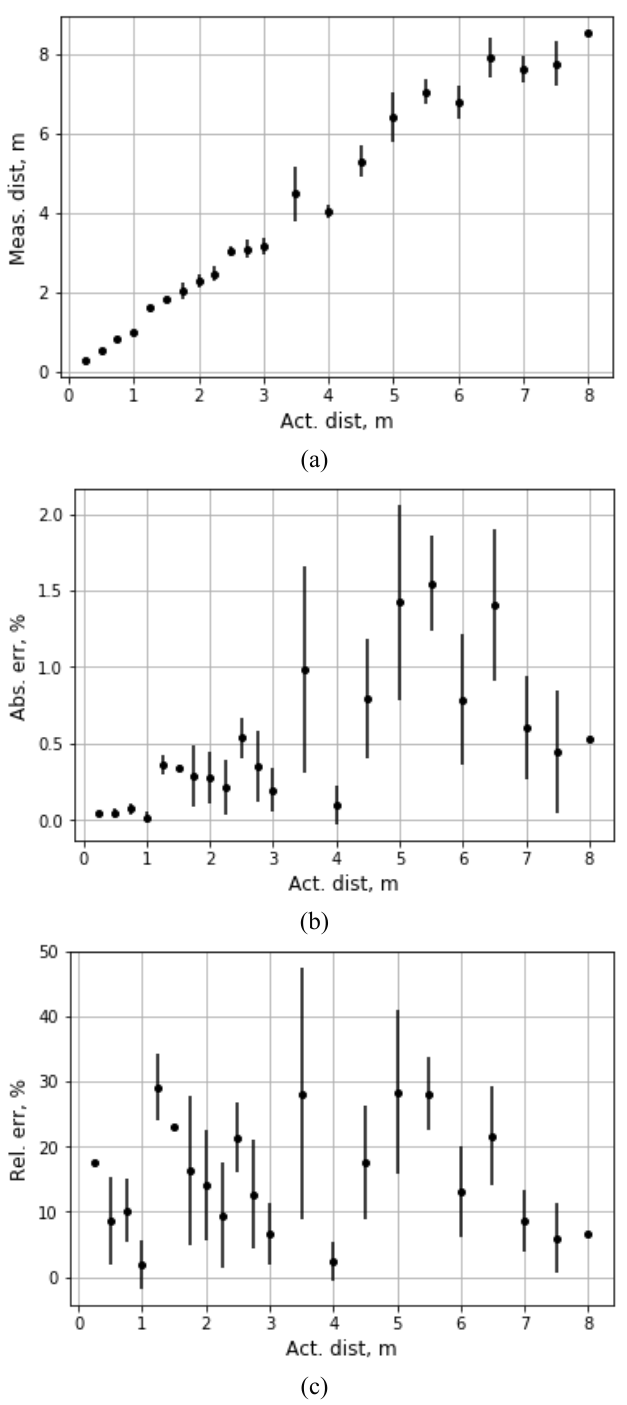
Fig. 4. Measurement results as functions of the actual distance. (a) measured distance estimate; (b) absolute measurement error; (c) relative